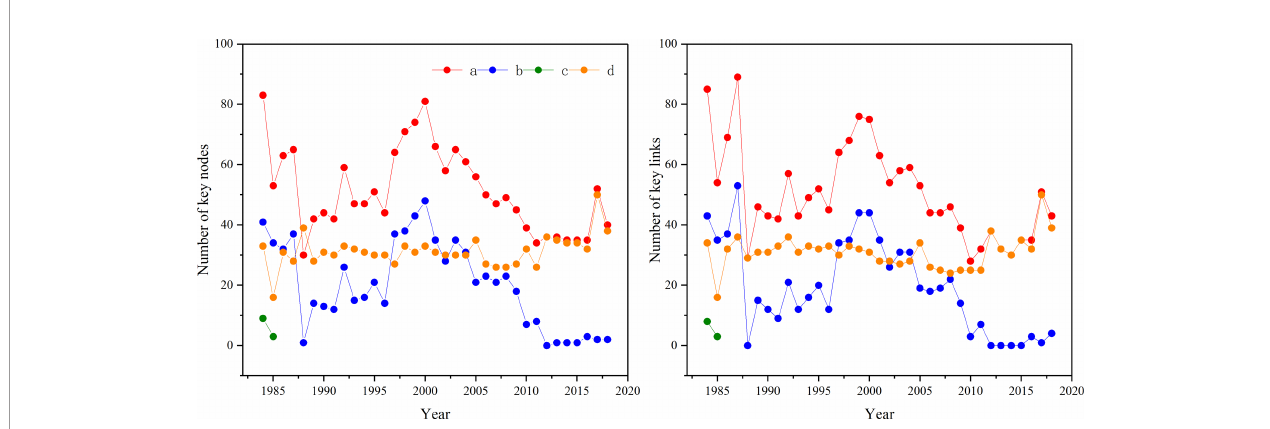
FIGURE 7 | Variation in the number of keynodes (or links) during 1984-2018 in the YRD (a represent the whole scale, b, c and d represent erosion zone, oil fi eld zone and deposition zone